Question: What type of chart is this?
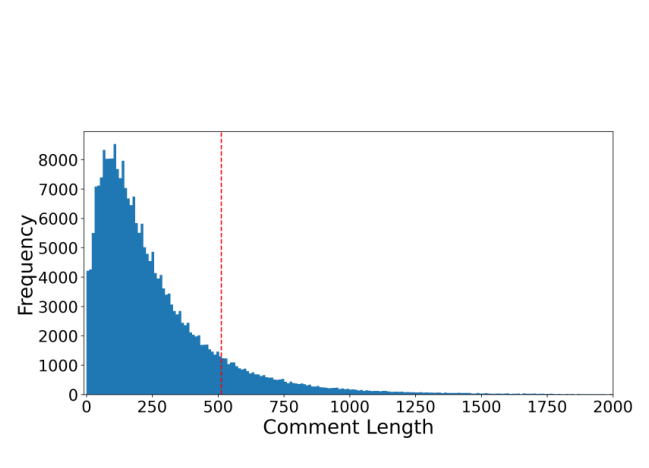
Answer: histogram